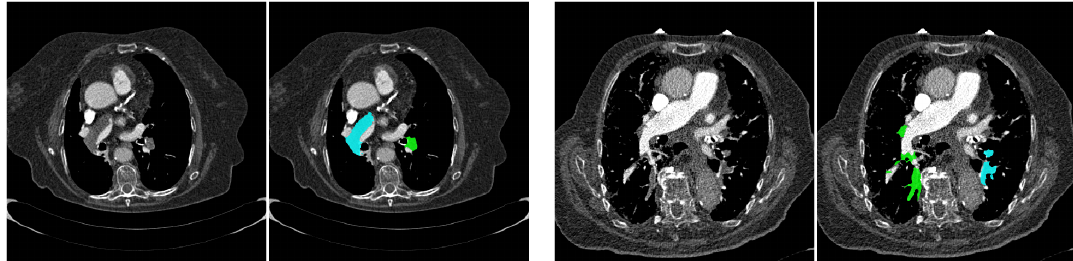
Figure 1. Two samples of the data used. Left side images represent an axial slice of a scan. Right side images represent the same image with the reference standard overlaid. Different colors represent unconnected